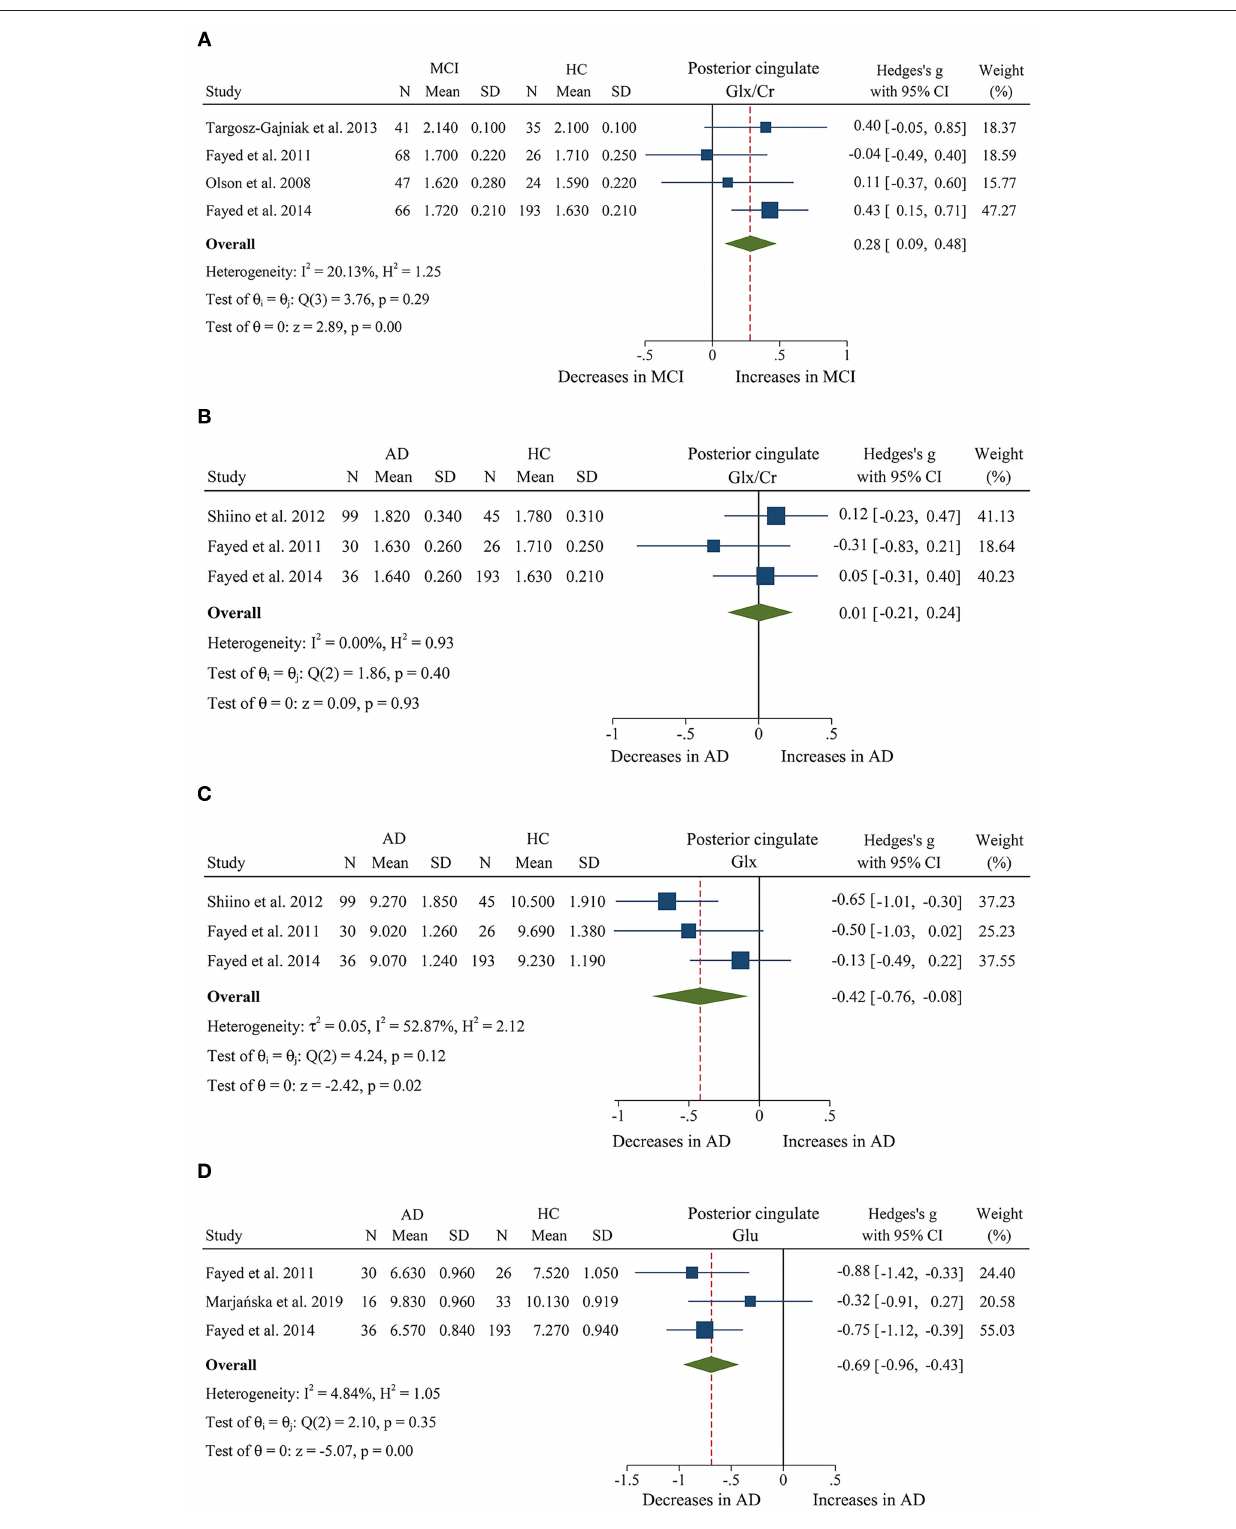
Frontiers in Aging Neuroscience |